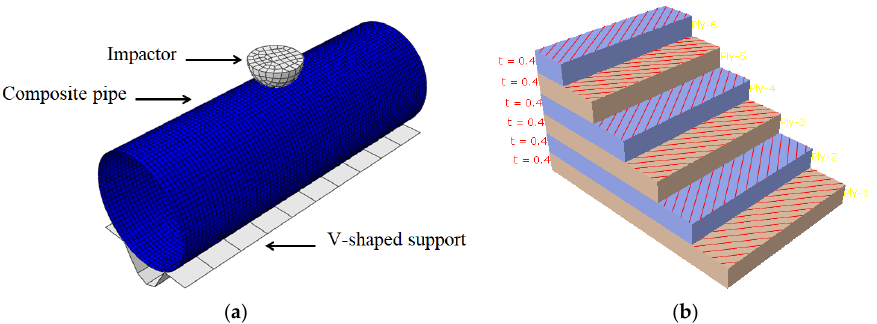
Figure 3. ( a ) FE model showing the composite pipe mesh, the impactor, and V-shaped support as a rigid solid, and ( b ) layup plot and material orientation (±55°).